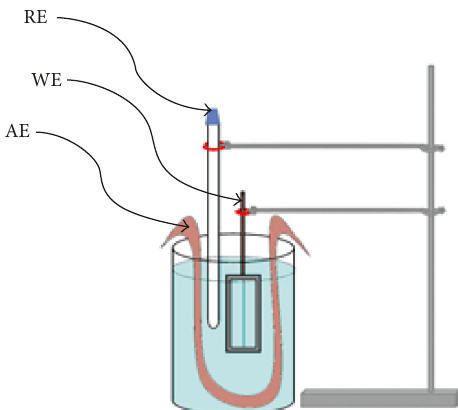
Figure 2: Schematics of three-electrode cell, standard calomel electrode as reference electrode (RE), CNT placed in PVC sample holder as working electrode (WE), and copper auxiliary electrode as anode (AE). Table 2: Used CNT fiber pretreatment methods. Treatment